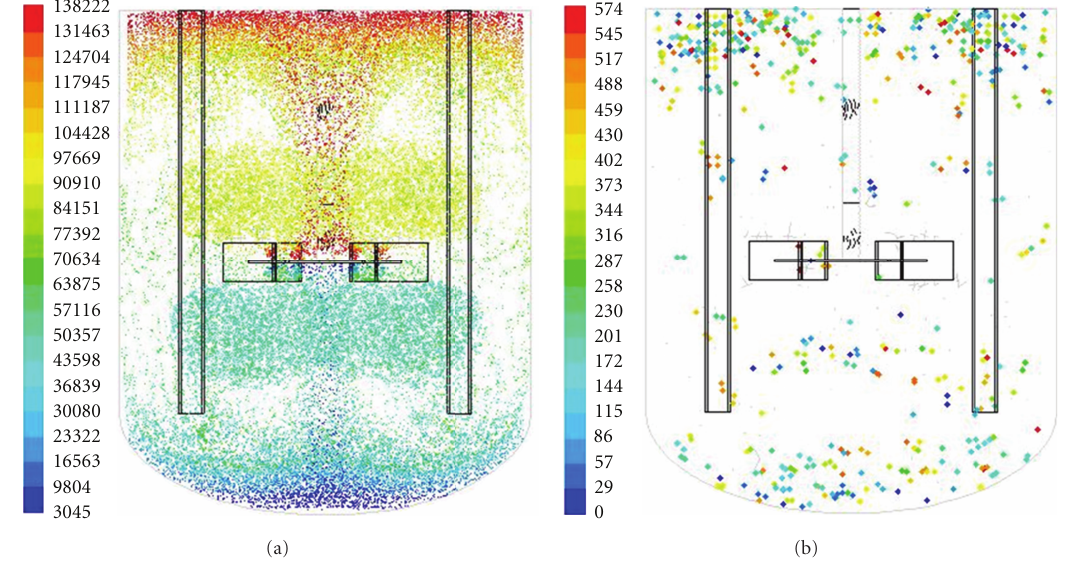
Figure 8: Simulation result of particle dispersion ( θ = 0 ◦ ).